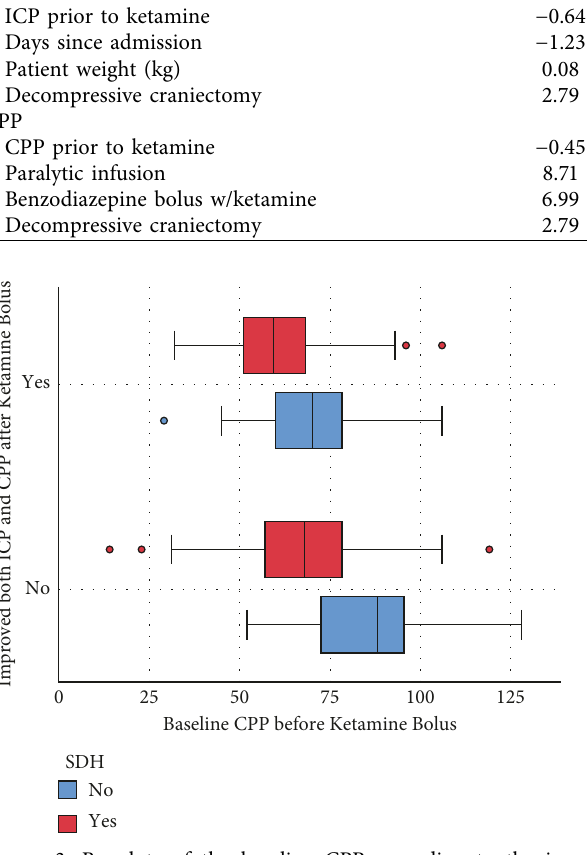
Figure 3: Boxplots of the baseline CPP according to the im- provement of both ICP and CPP and the presence of SDH. Patients who had lower CPP and the presence of a SDH showed greatest improvement in both ICP and CPP values after a ketamine